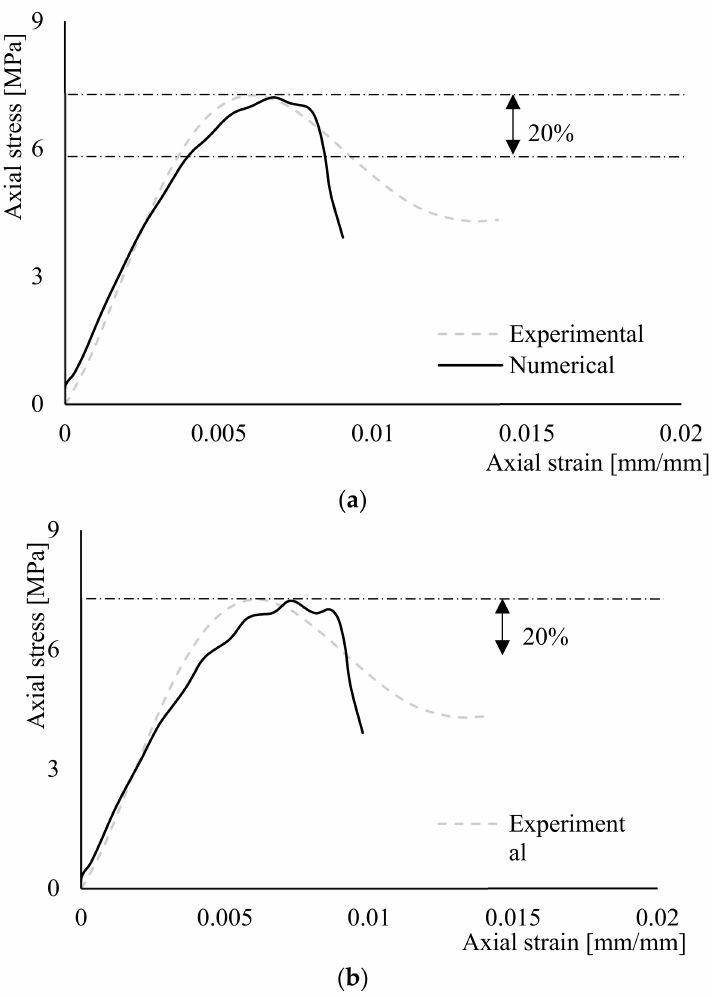
Figure 10. Comparison results for unreinforced column between the numerical and experimental curve reported in Cascardi et al. [65]: ( a ) SIIMI and ( b ) MI